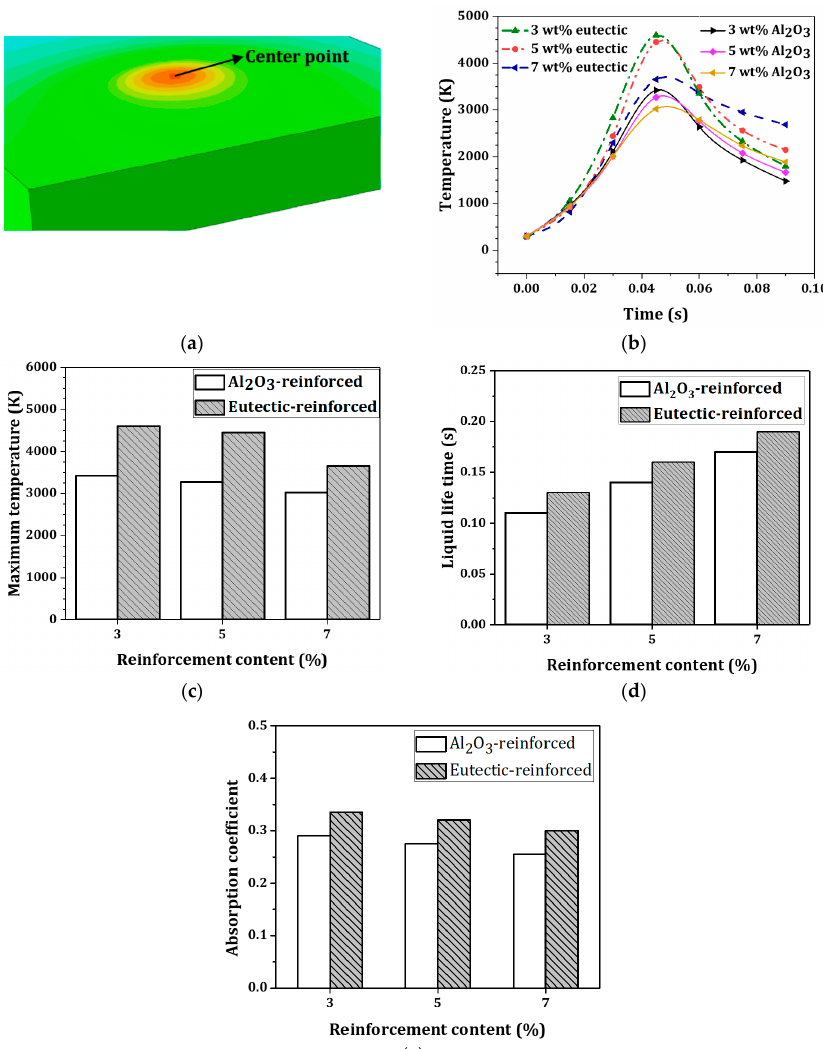
Figure 6. ( a ) Center point on the top surface chosen for plotting the ( b ) Temperature-time curves. ( c ) Results for the maximum temperatures of the reinforced samples. ( d ) Liquid lifetimes. ( e ) The final estimations of the absorption coefficients.